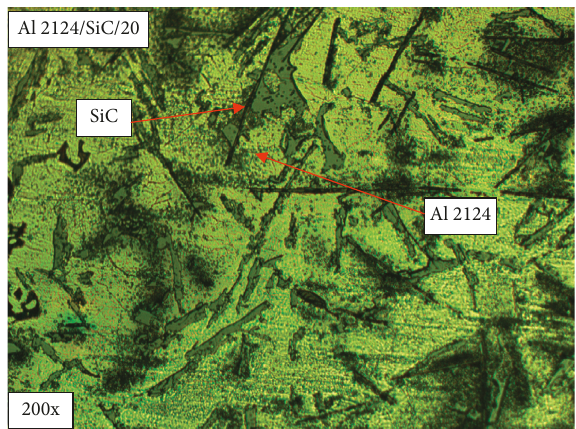
Figure 15: Microstructure at 200x (after itching) shows eutectic Si and SiC particle in the matrix of α –aluminium (for AlSiC20%).